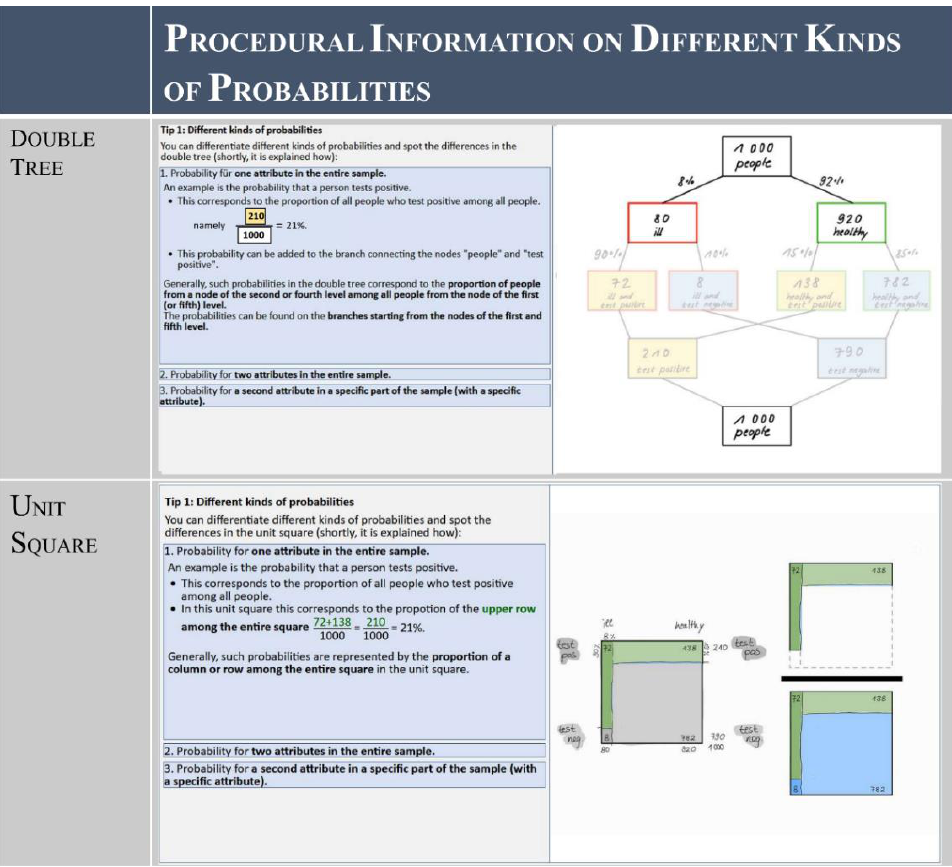
Figure 8. Screenshot of the procedural information on different kinds of probabilities. Other aspects of procedural information can be seen as well: the visualizations are hand-drawn, and the textual phrasing of the probability is complemented by a wording of proportions.